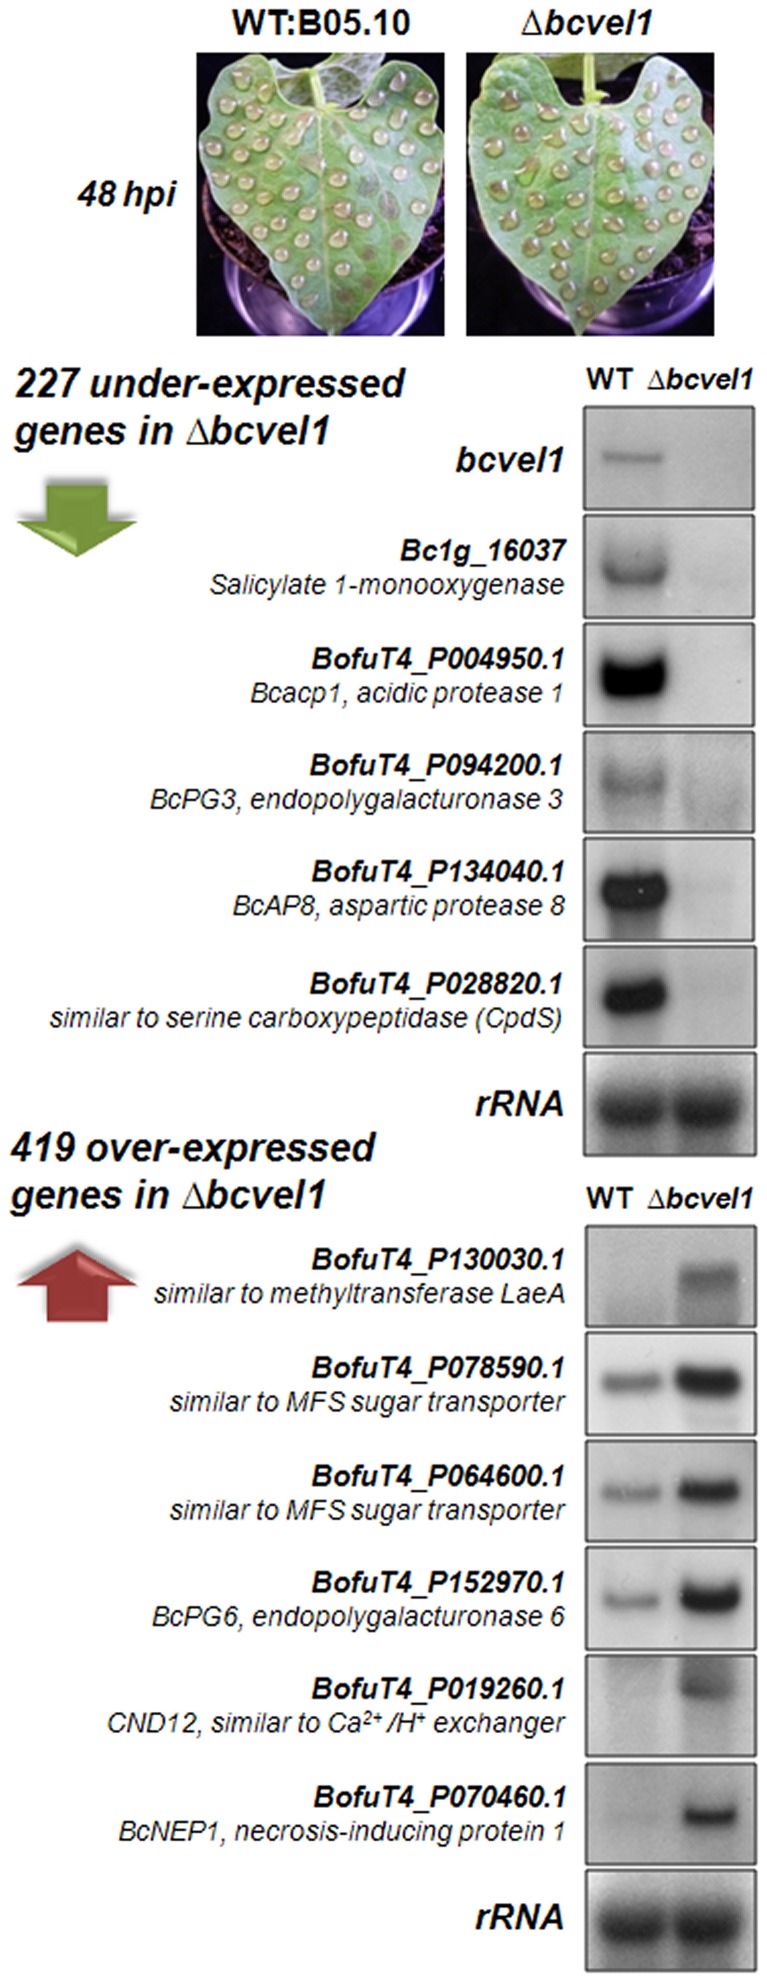
Analysis of the BcVEL1-dependent expression profile during infection.Primary leaves of living P. vulgaris plants were inoculated with many droplets of conidial suspensions of the wild-type strain B05.10 and the Δbcvel1 deletion mutant, respectively. Infected plant material (from four biological replicates) was sampled at 48 hpi before infections started to spread. RNA was extracted, labeled and hybridized to B. cinerea microarrays. The comparative analysis of the array data revealed 227 genes that were under- and 419 genes that were over-expressed in the Δbcvel1 mutant (for details see Tables S1, S2; Fig. S9). Expression profile of some arbitrarily chosen genes was confirmed by northern blot analyses.